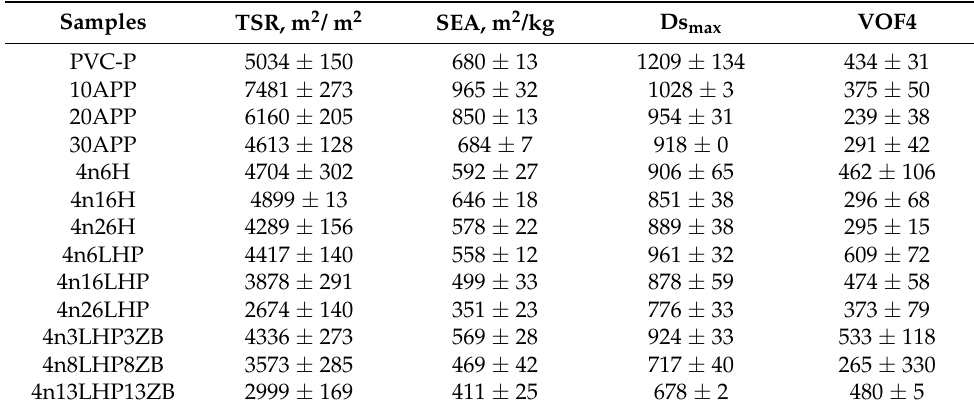
Table 5. Cone calorimeter results of PVC-P and